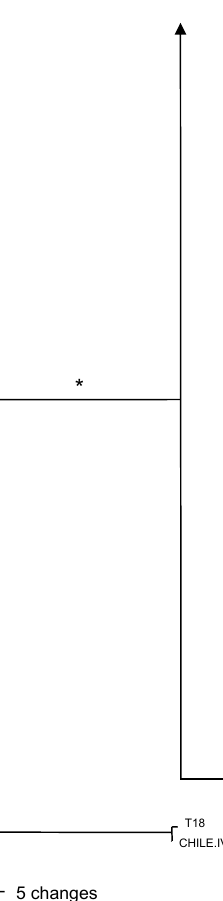
Figure 3. One of 10 most parsimonious trees obtained from heuristic searches of the ITS sequences (length: 2050 steps; CI: 0.560; RI: 0.938; RC: 0.526) of the Basidiomycete isolates. Bootstrap support values (1000 replicates) are shown above the nodes and bootstrap values of 100 % are indicated by an asterisk (*). The outgroups used were Stereum hirsutum isolates T18 and Chile IV. From White et al. (2011a). (continued on next